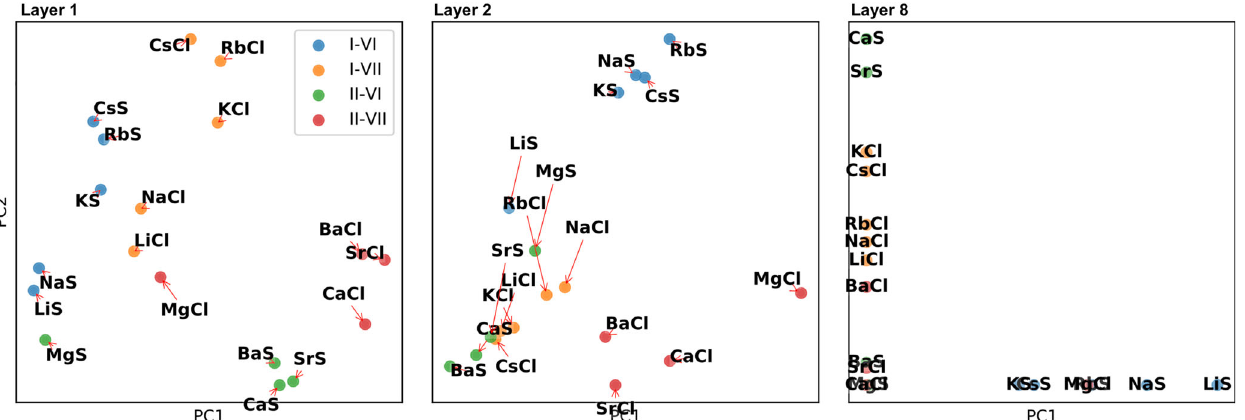
Fig. 11 Network intermediate output (activation) inspection example. The authors predict material property from elemental composition inputs with a fully connected neural network. They then examine network activations by compressing the activations of different materials with PCA and plotting the fi rst two PCs. Results show that intermediate network layers can learn essential chemical information. Early network layers tend to learn the presence of elements and later network layers tend to learn the interaction between elements (e.g., charge balance). Figure reprinted from ref. 89 under the CC-BY 4.0 license 156